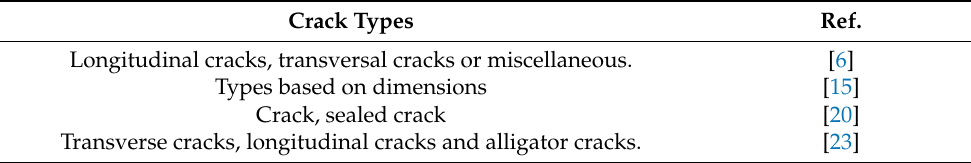
Table 3. Studies focusing on crack classification. Crack Types Ref. Longitudinal cracks, transversal cracks or